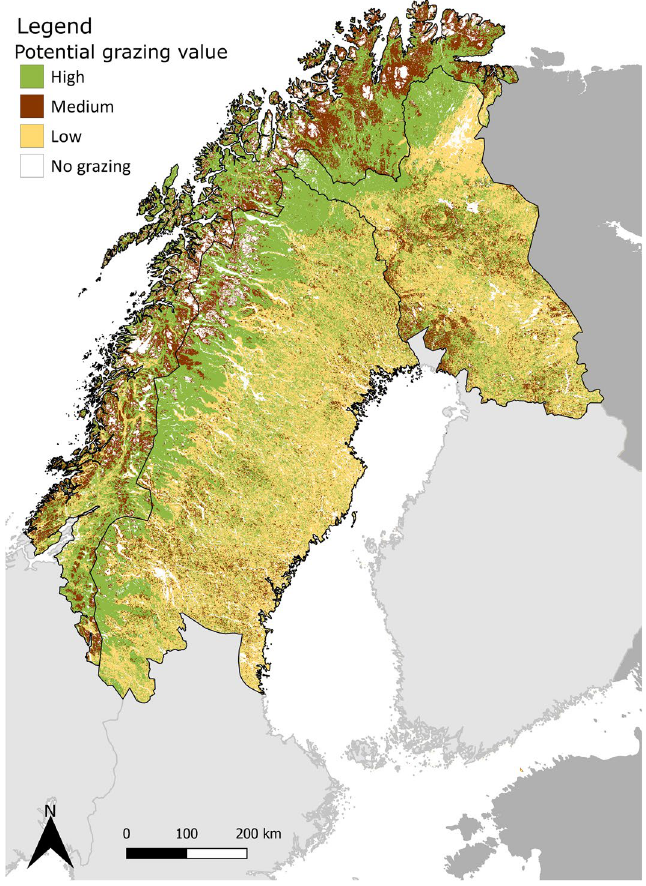
Figure 1. Map of the potential grazing values in summer pastures of northern Fennoscandia. The reclassification is based on Corine land-cover 2018 (detailed in Table 1). This map was created with QGIS version 3.4.7, accessed on www. qgis. org. The country borders were from Eurostat